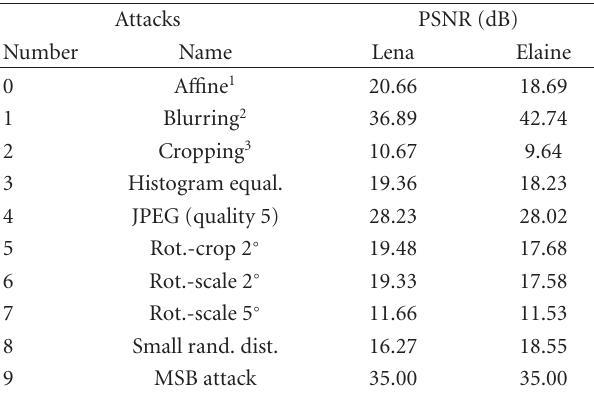
Table 3: Attacks considered while designing the